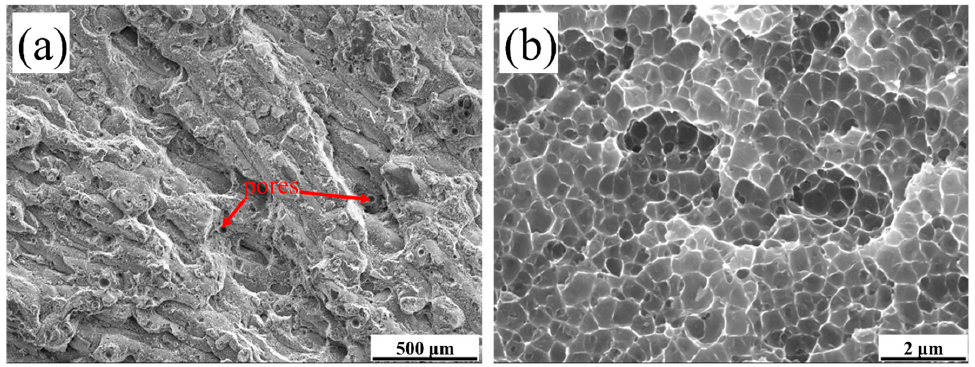
Figure 15. SEM photos of tensile fracture surface of the A3 in as ‐ processed status: ( a ) ×50; ( b ) ×10,000.